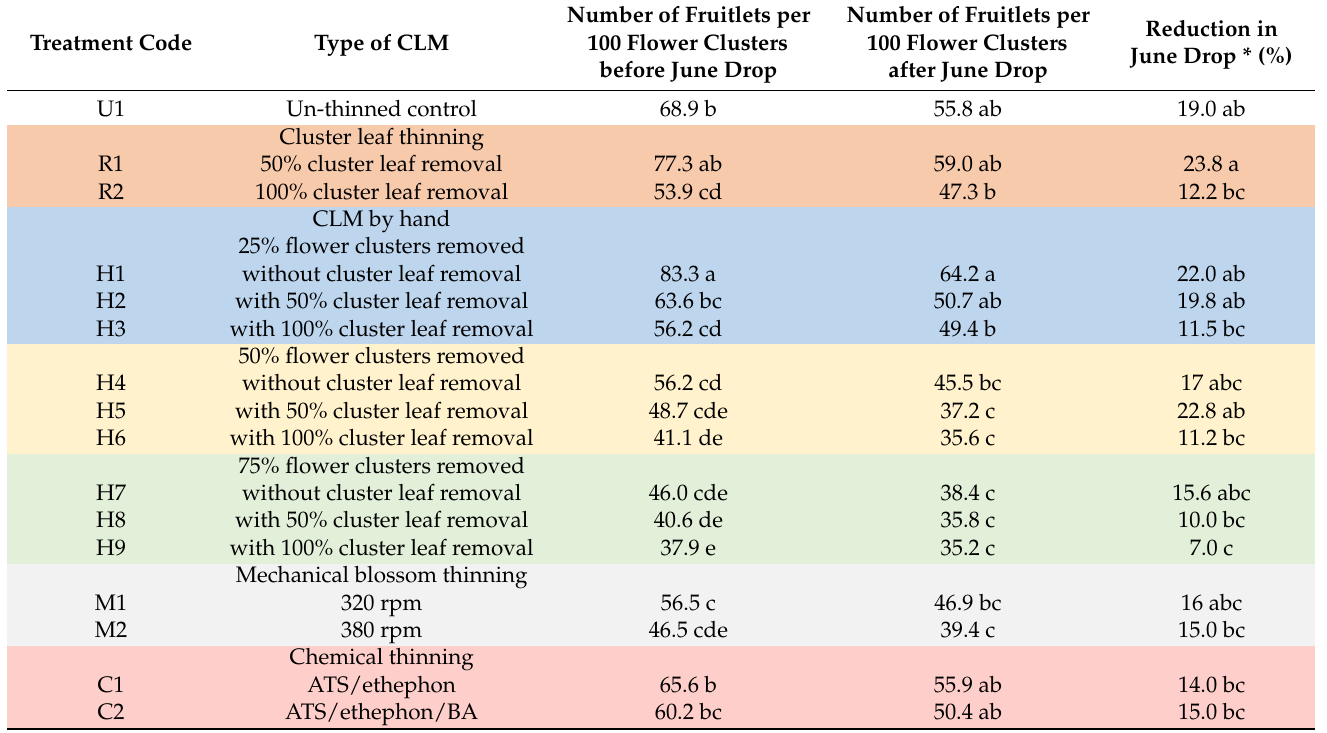
Table 2. Effect of crop load management (CLM) on number of fruitlets before and after June drop and fruit reduction in June